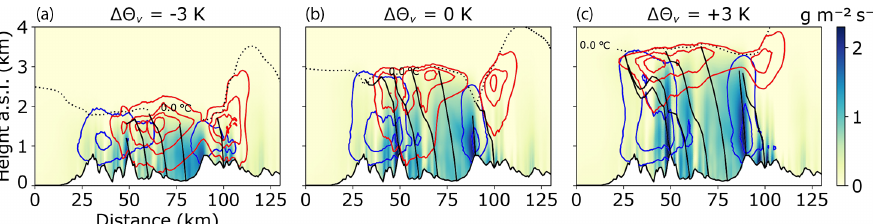
Figure 7. Rainwater flux (shading) and raindrop trajectories (black) at 18:30UTC (shading) together with contours of 6h averaged melting (red) and accretion (blue) rates at { 1 , 5 , 10 , 15 } gm − 3 h − 1 . The panels show the (cid:49)(cid:50) v = − 3K (a) , (cid:49)(cid:50) v = 0K (b) and (cid:49)(cid:50) v = + 3K (c) simulations. Orography is displayed at the bottom.